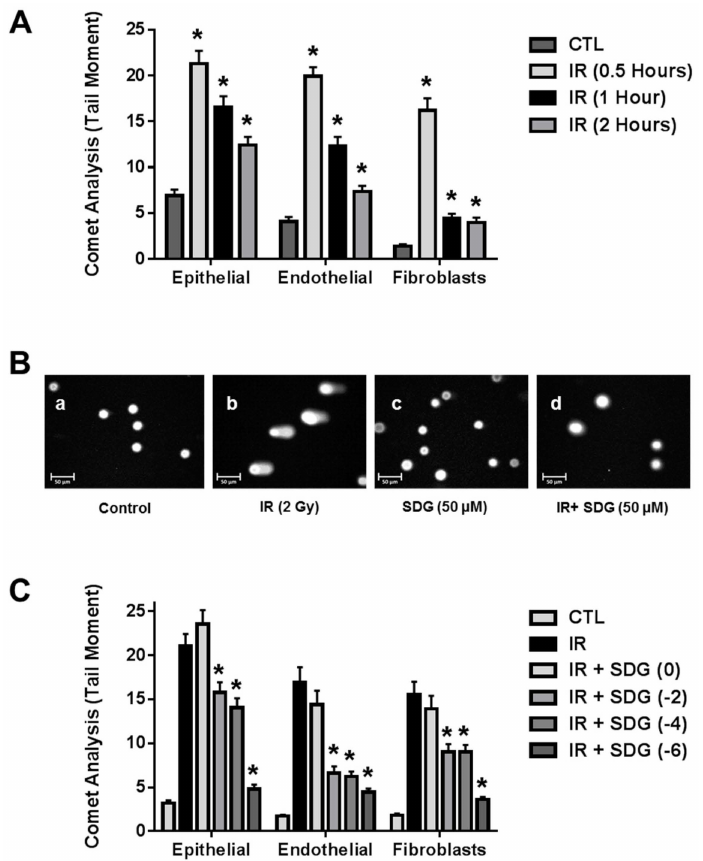
Figure 1. Evaluation of the radiation-induced DNA single-strand breaks (SSB) in lung cells using the alkaline comet assay. ( A ) Kinetic evaluation of DNA damage in irradiated lung cells (epithelial, endothelial and fibroblasts) with 2 Gy; * p ď 0.001 for non-irradiated controls vs. their respective irradiated cells; ( B ) Representative fluorescence photomicrograph of lung epithelial cells at 400 ˆ magnification. Cells were pre-treated with SDG (50 µ M) and exposed to γ -rays (2 Gy). Image a: Control cells, Image b: SDG (50 µ M), Image c: IR (2 Gy) after 30 min of exposure, and Image d: Cells pre-treated with SDG (50 µ M, 6 h) and irradiated; ( C ) Effect of SDG (50 µ M) treatment (0, 2, 4, and 6 h prior to irradiation) on irradiated lung cells. Data are represented as mean ˘ SEM. * indicates p < 0.05, for irradiated cells vs. SDG pre-treated irradiated